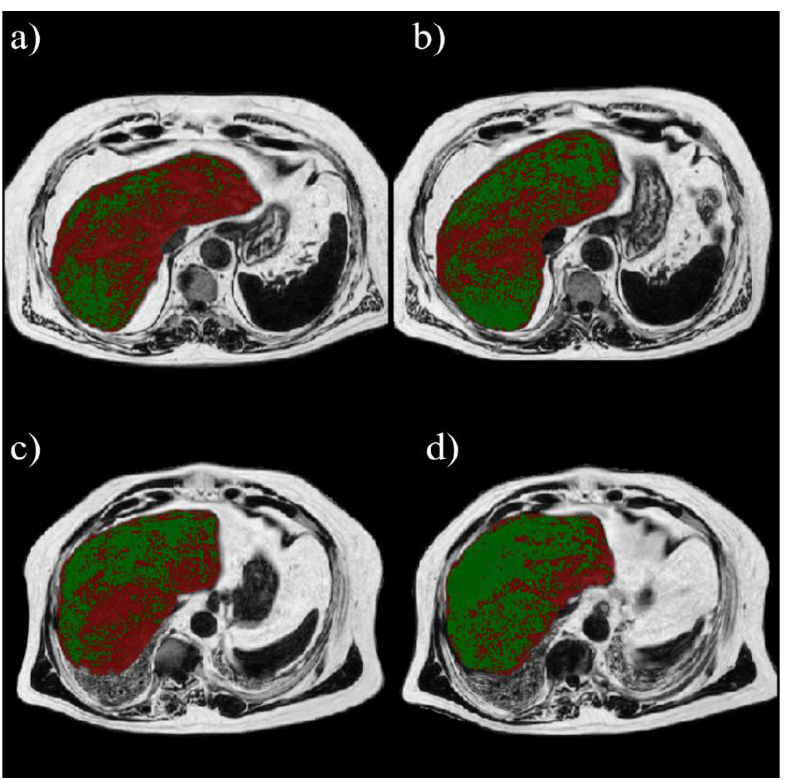
Figure 2. Examples of volumetric analysis. On the first row, a patient who underwent MUFA diet with percentage of liver volume with MRI-PDFF > 5.56% (red) decreasing post-treatment ( b ) with respect to pre-treatment ( a ) of 24.4%. On the second row, a patient who underwent multifactorial diet with percentage of liver volume with MRI-PDFF > 5.56% (red) decreasing post-treatment ( d ) with respect to pre-treatment ( c ) of